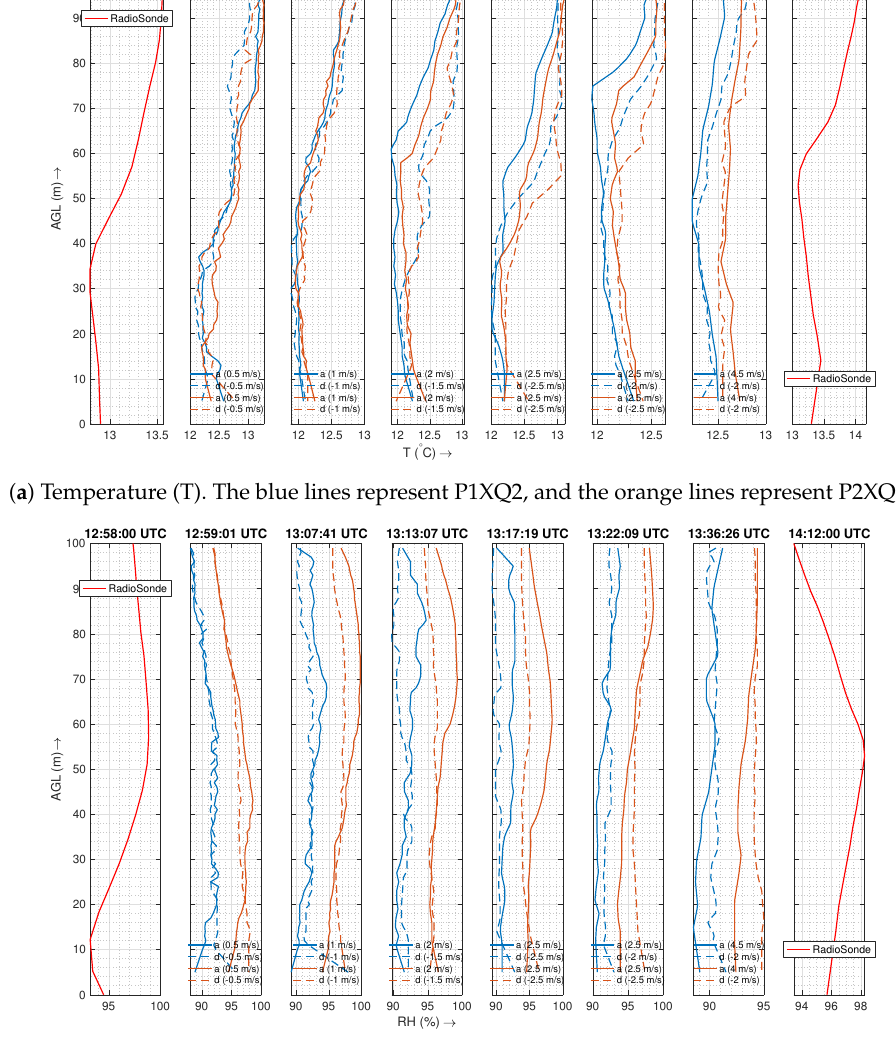
( b ) Humidity (RH). The blue lines represent P1XQ1, and the orange lines represent P2XQ2. Figure 11. The plot shows two radiosonde flights (filtered and corrected) and six different flights of the UAS (not filtered/corrected) at different speeds in a inversion layer. The surface wind was 2 m/s from 290–308 ◦ relative to north and with a partly cloudy sky. The P1XQ2 sensor is upstream, while the P1XQ1 and P2XQ2 sensors are downstream from the UAS with respect to